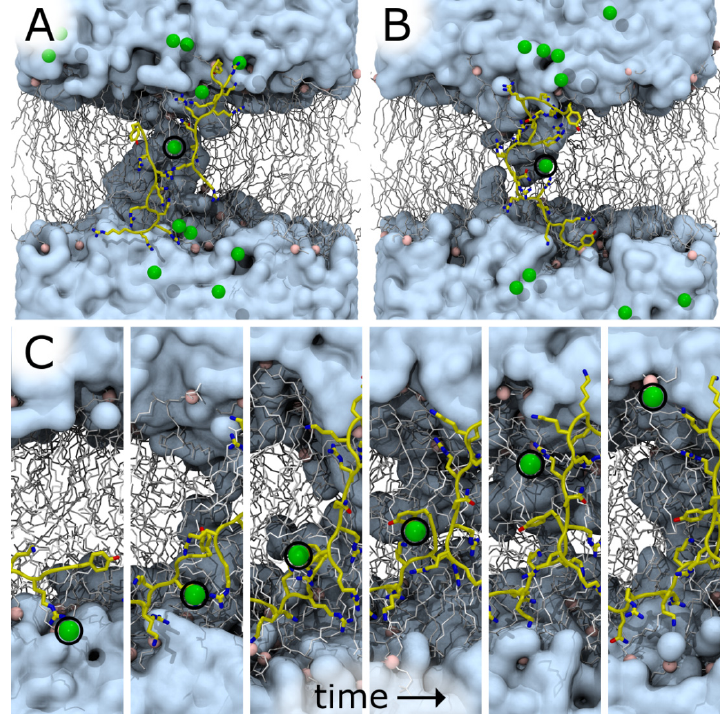
Figure 9. Chloride ion occupancy in the interior of a DOPC:DOPE (1:1) bilayer in simulations at z = 8 Å, A L = 72 Å 2 , x = 0.015. ( A , B ) Snapshots at 100 ns in two representative simulations with different initial conformations. χ 2 values for these simulations are 3.1 ( A ) and 2.8 ( B ). ( C ) Sequential snapshots along a simulation time trajectory in which a Cl − ion crossed the bilayer ( χ 2 = 3.3). Water is cyan, lipids are gray, lipid headgroup phosphorus atoms are pink, protein is yellow, and Cl − is green. Protein and ions are rendered in front of all other molecules for clarity. A black circle is drawn around some